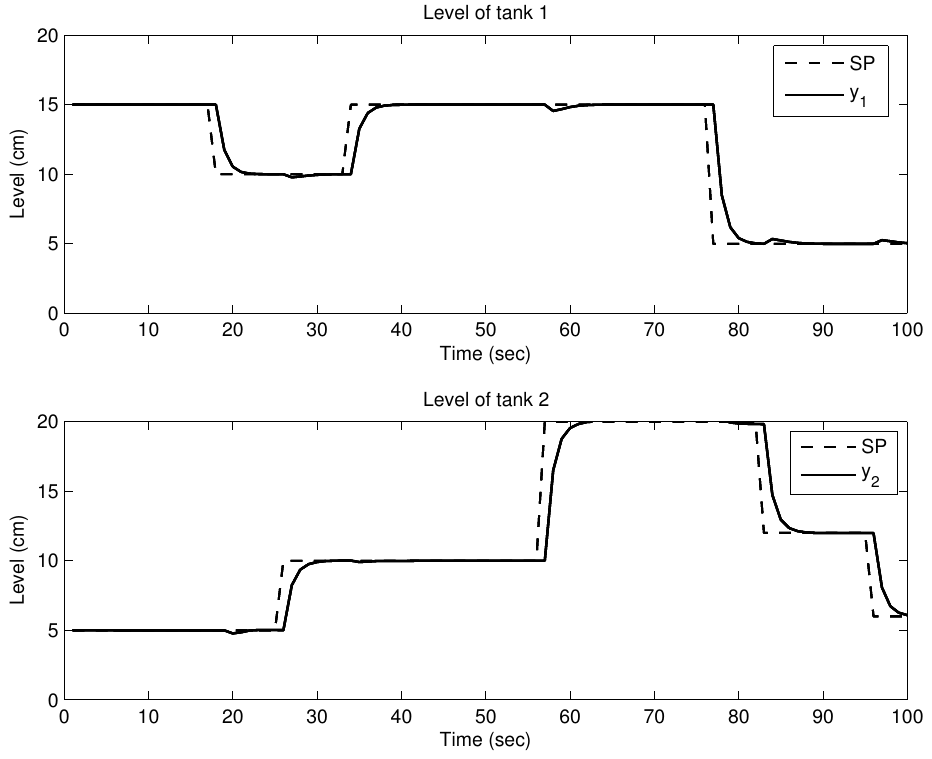
Figure 8. MIMO-APC control in non-minimum phase